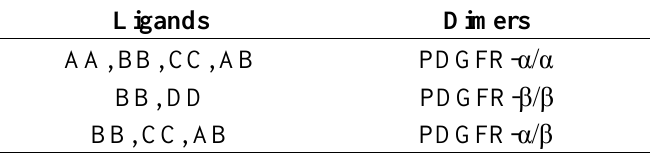
Table 3. PDGFR family members and their ligands. Different PDGF